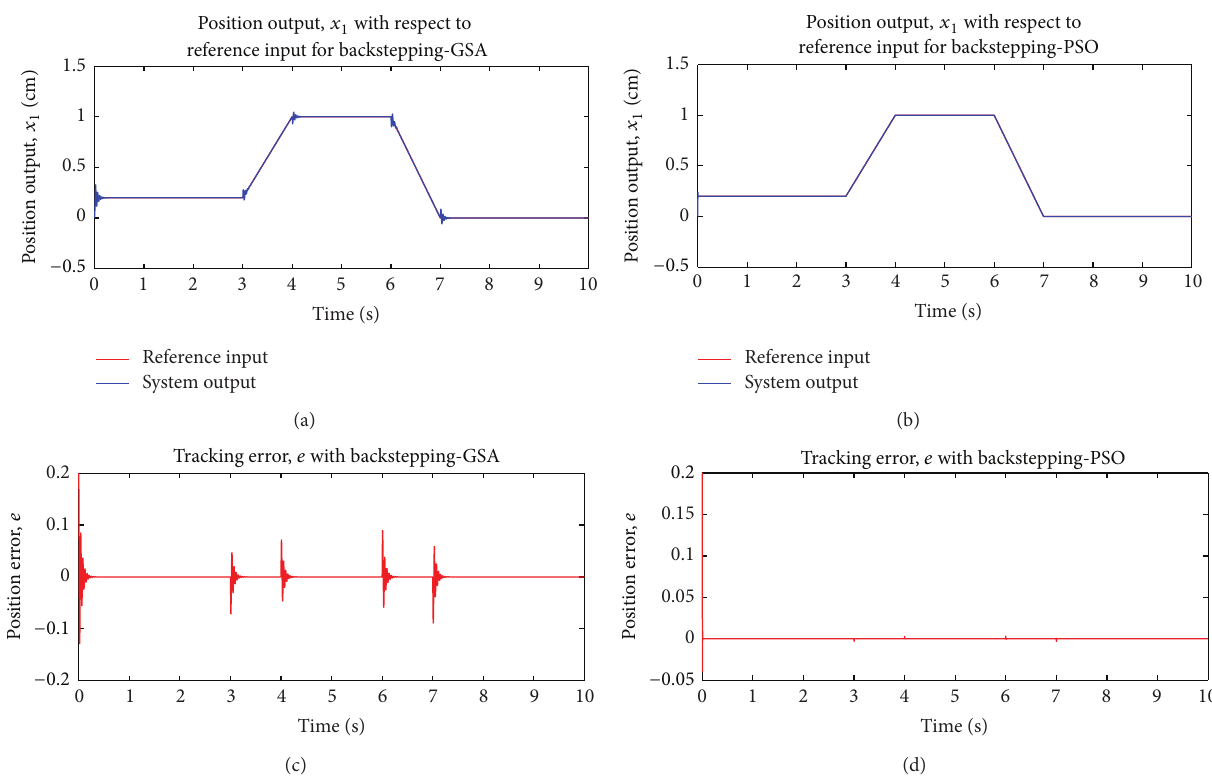
Figure 5: Position output with respect to reference input given and tracking error for backstepping-PSO and backstepping-GSA without disturbance.